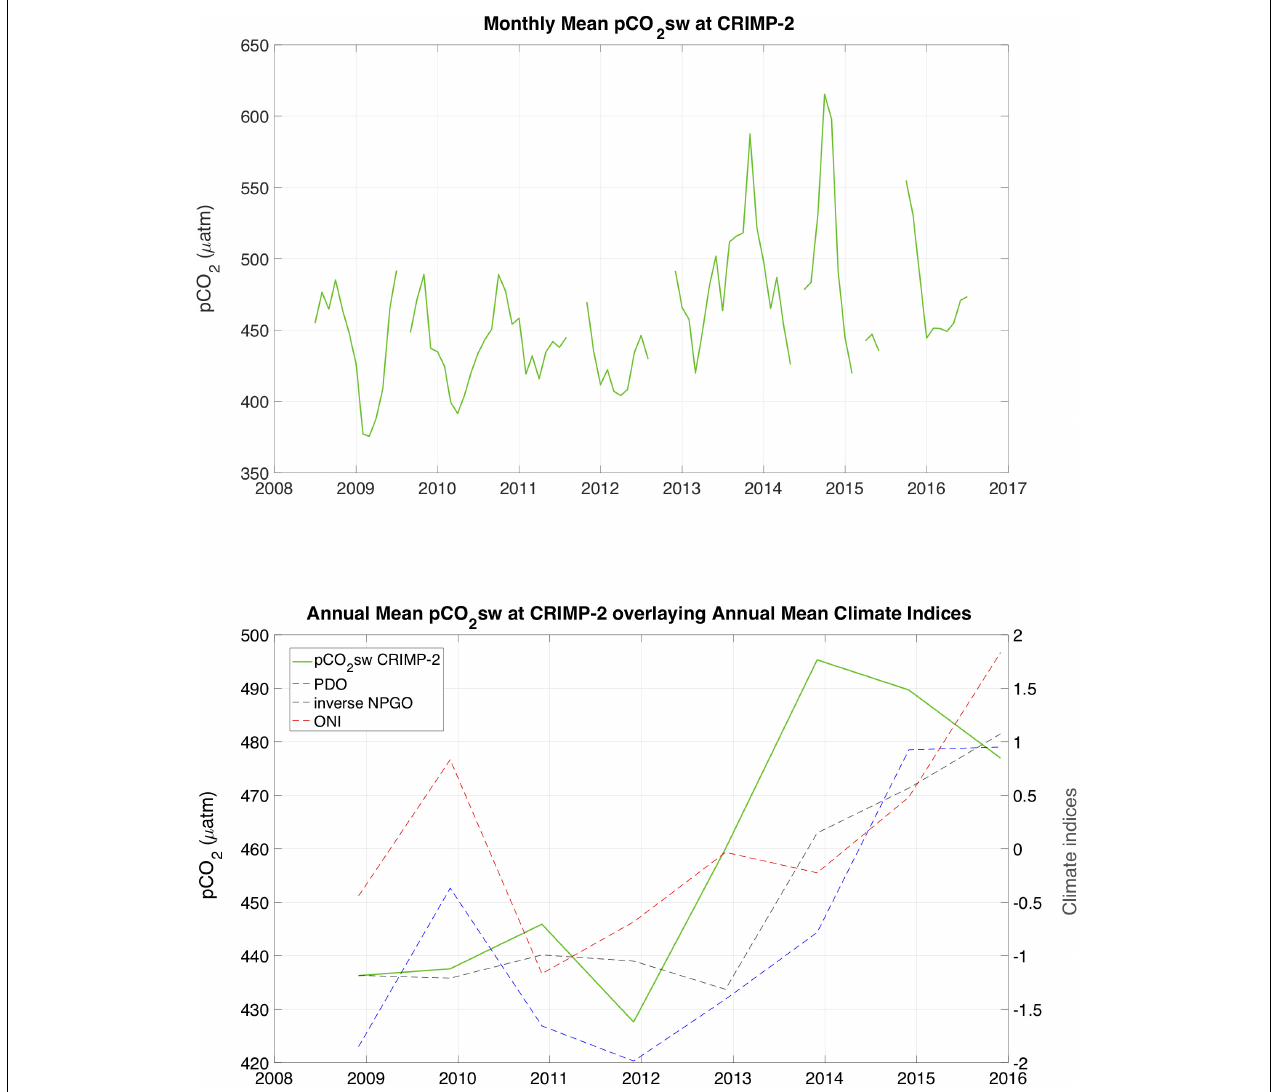
FIGURE 8 | Time-series of Monthly Mean (top) and Annual mean (bottom) p CO 2 sw at CRIMP-2 from June 2008 through June 2016. Annual means of p CO 2 sw calculated from June of 1 year to May of the next. The dashed curves in the bottom panel show annual mean values of the Pacific Decadal Oscillation index (PDO, blue), Oceanic Nino Index (ONI, red), and the inverse of the North Pacific Gyre Oscillation index (NPGO,